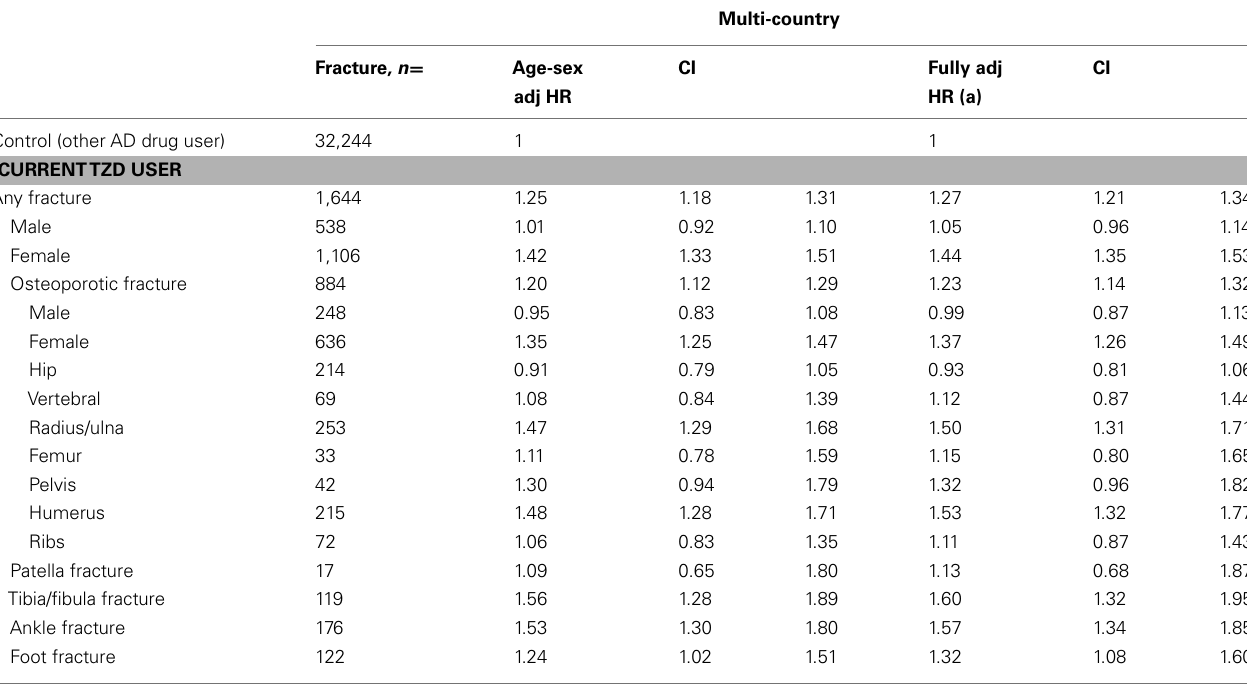
Table 5 | Multi-country: risk of fracture in currentTZD users compared with other antidiabetic users, by type of fracture and